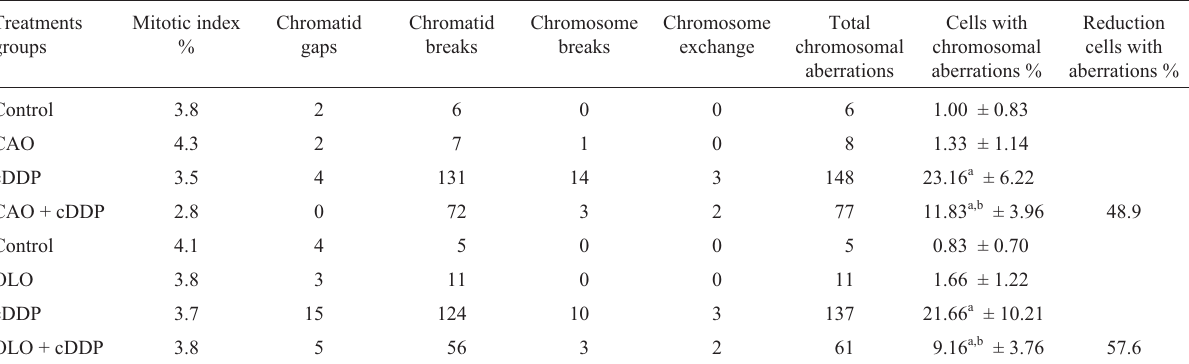
Table 1 - Mitotic index, and distribution of different types of chromosome aberrations, in bone marrow cells of Wistar rats pretreated with canola oil (CAO), olive oil (OLO), cisplatin (cDDP) and their respective controls. Treatments groups